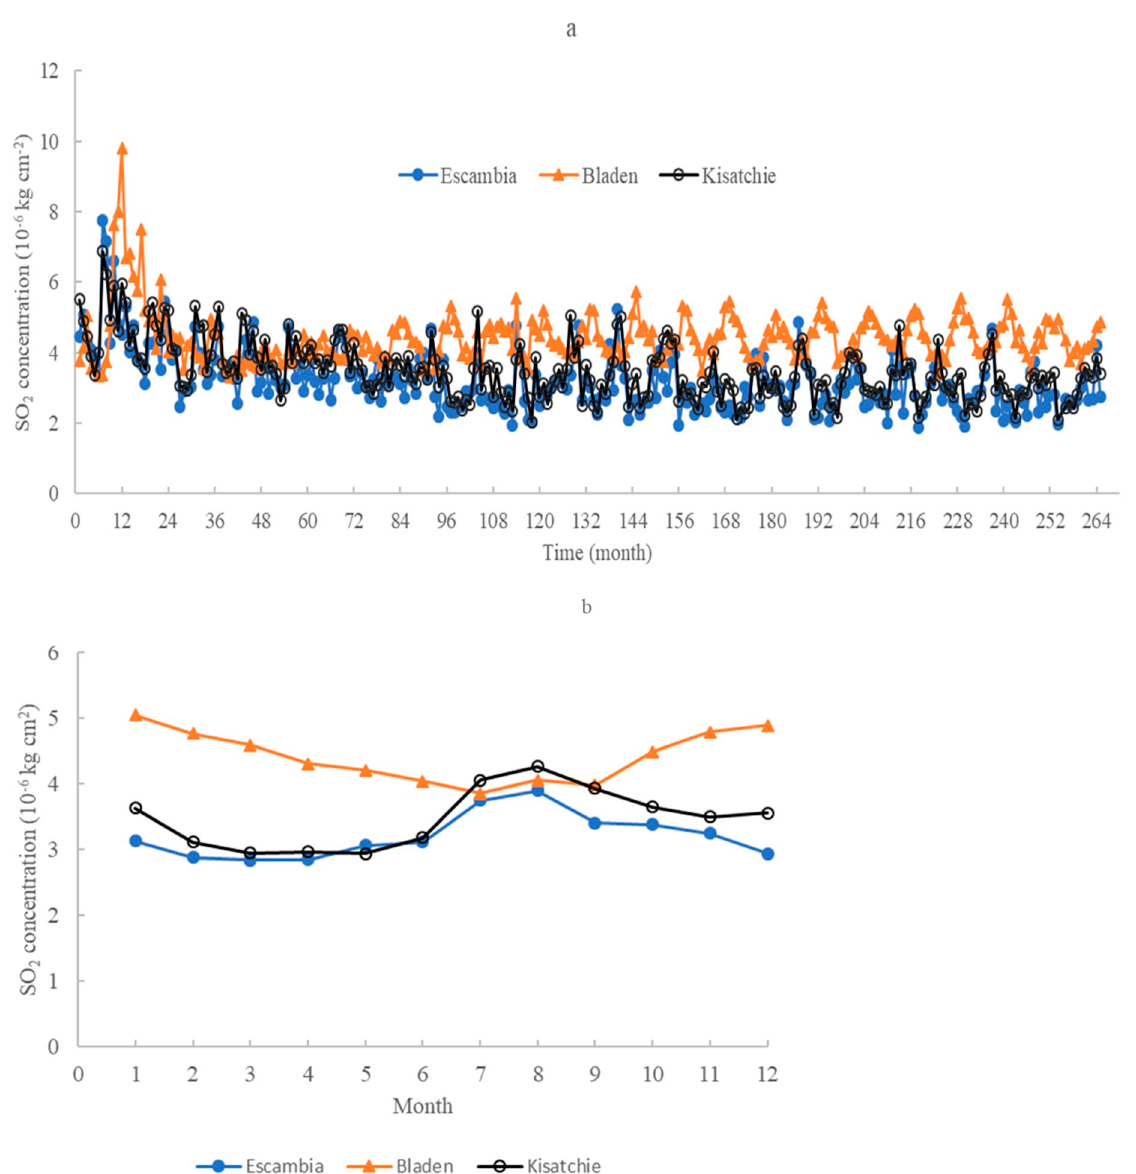
Figure 7. Dynamics of SO 2 column mass density in Escambia, Bladen, and Kisatchie. ( a ) Monthly and yearly SO 2 column mass density from January 2000. ( b ) The integrated monthly average SO 2 column mass density.